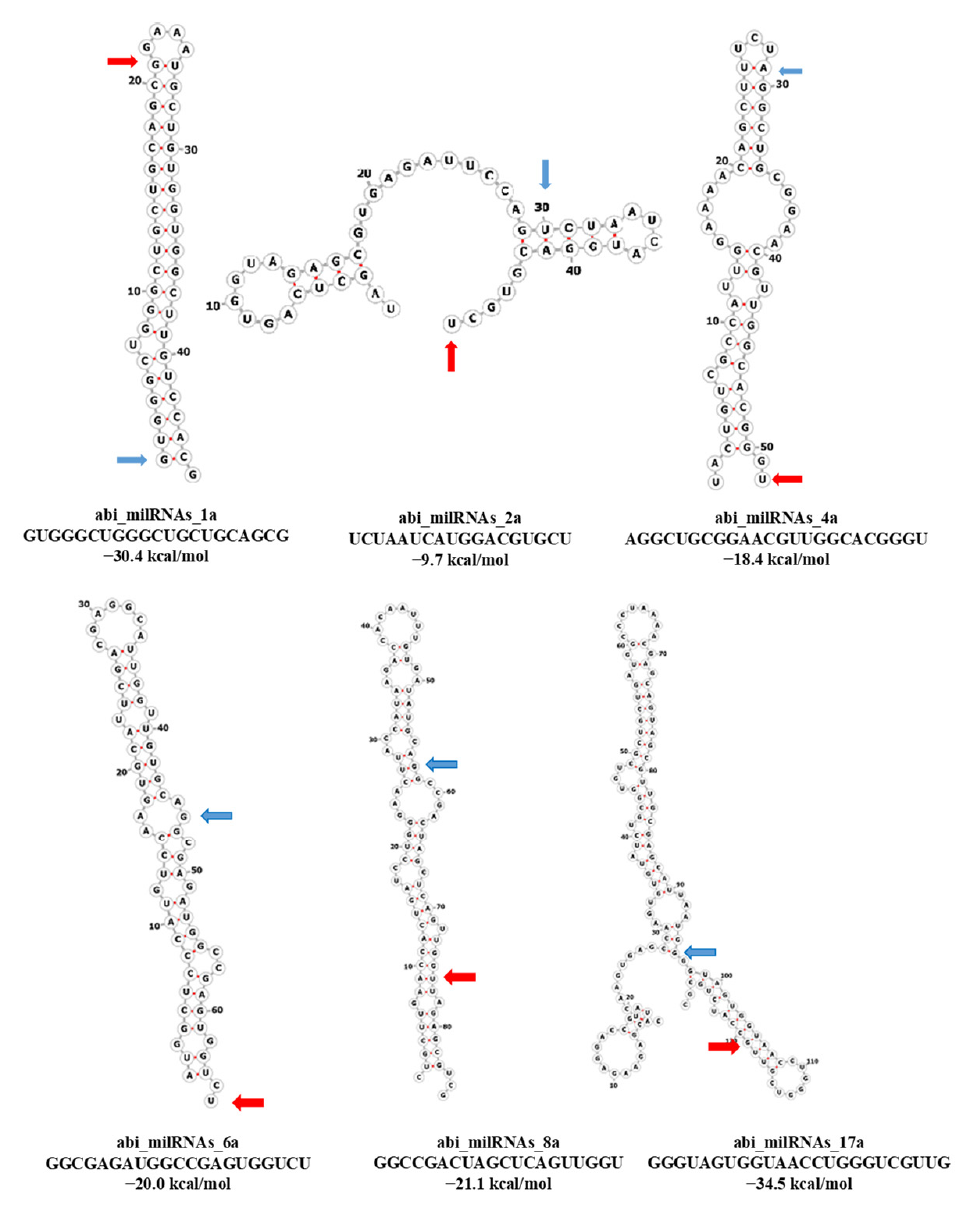
Figure 4. Secondary structures proposed for abi_milRNA precursors (abi_milRNA_1a, 2a, 4a and 6a are representative of those predicted by animal criteria and 8a and 17a of those with high homology with other fungi). The corresponding mature milRNA sequence and the estimated free energy of the pre-miRNAs are also indicated. Blue arrow: start mature sequence. Red arrow: end mature sequence. Table 2. Agaricus bisporus milRNA (microRNA-like) candidates predicted by miRDeep2 (and miARma-Seq) and miRPlant. Reads correspond to number of reads. L: length. Pre-miRNA position corresponds to H97 assembly for miRDeep2 group and to H39 for miRPlant one.